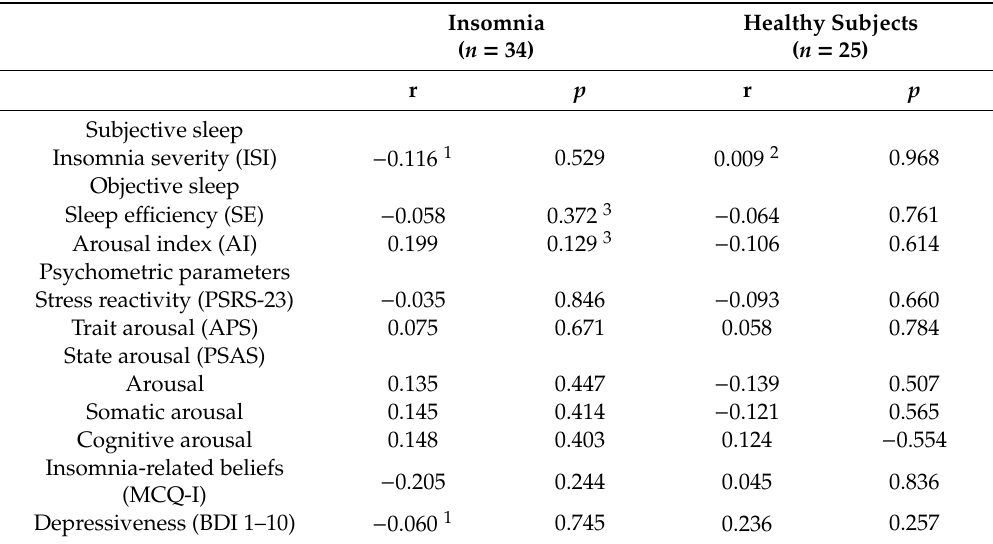
Table 2. Correlations of the Arousal stability score with subjective and objective sleep parameters and psychometric